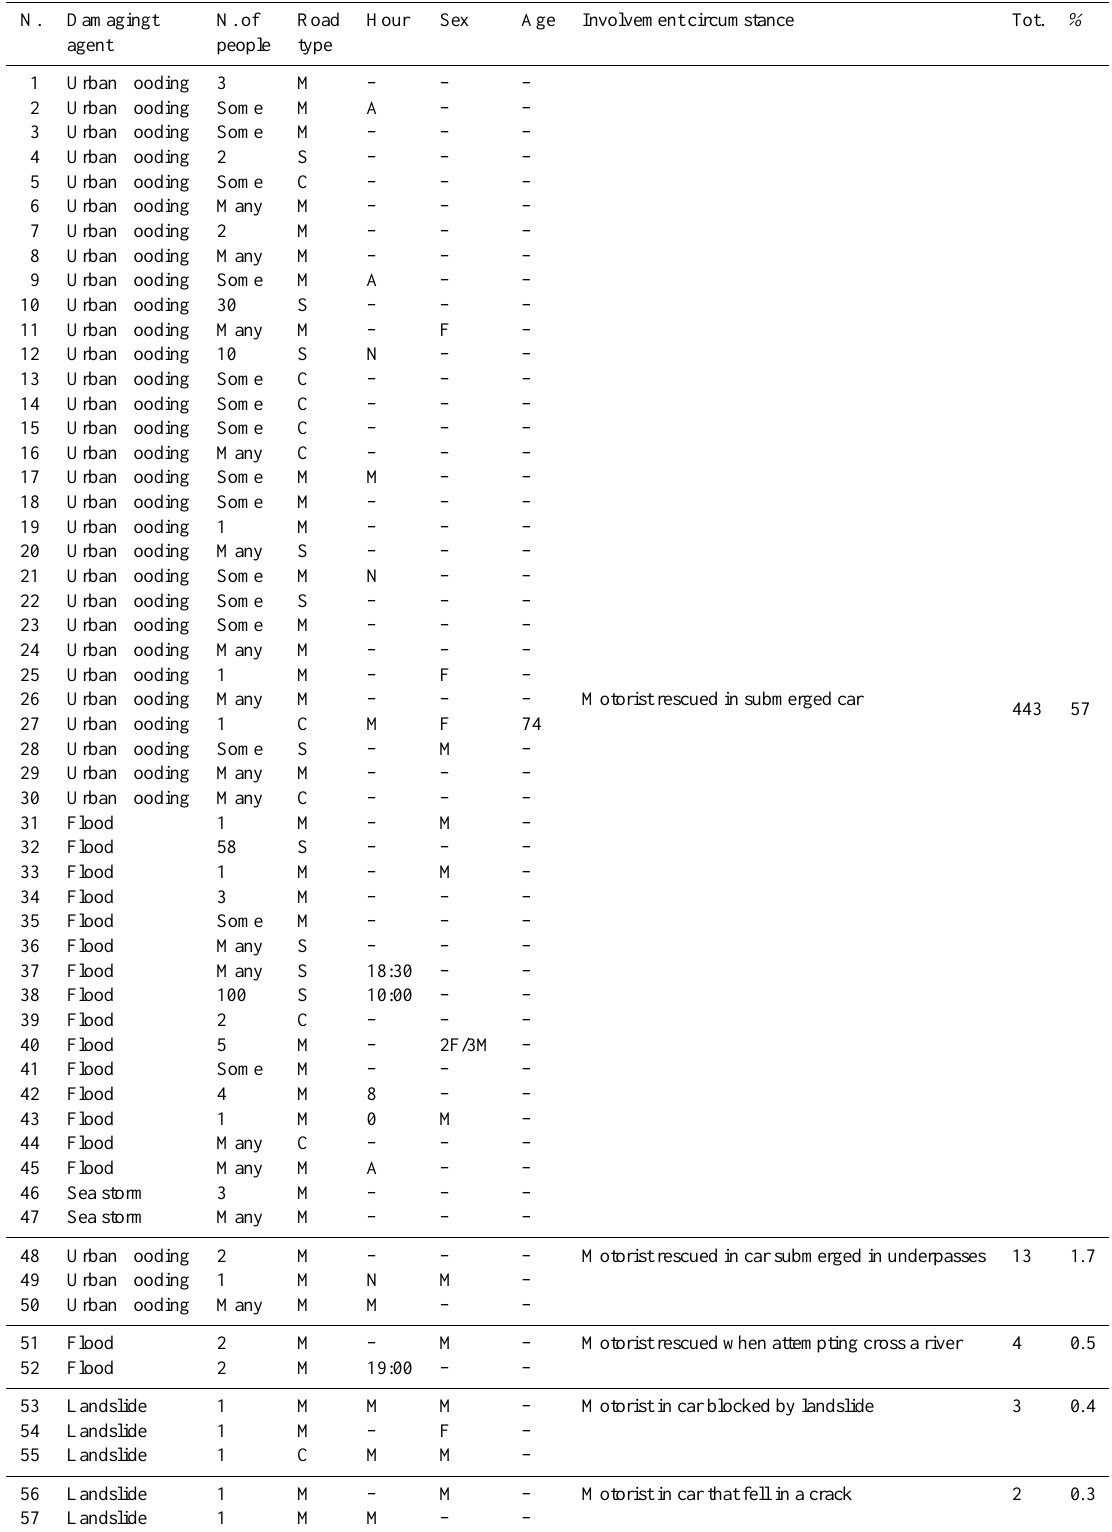
Table 4. Cases in which people were involved. For each record, the following data are reported: damaging agent, number of people involved, road type (H = Highway; S = State road; C = County road; and M = Municipal road), time at which the damage occurred (A = afternoon, M = morning, N = night, S = sunrise), sex of people involved, age of people involved (Ad = adult; Ch = child), and circumstance.